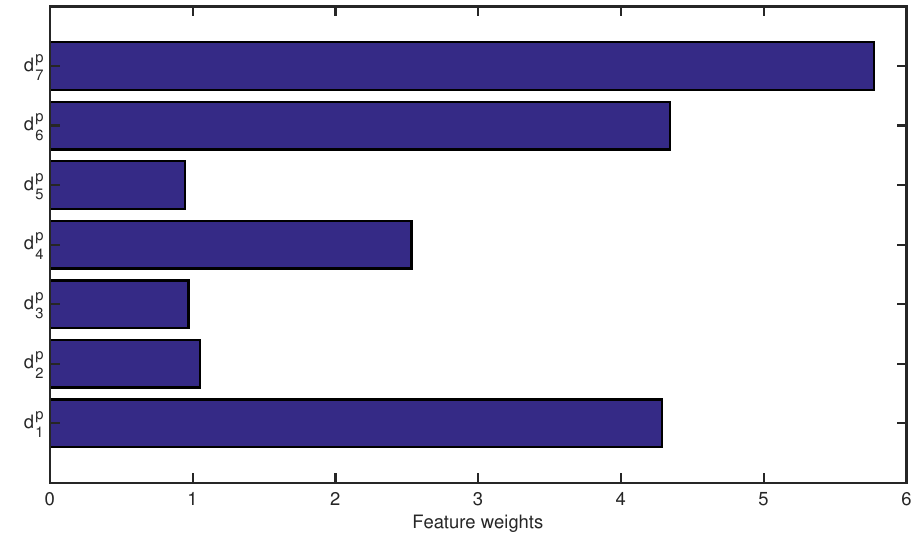
Figure 9. The optimal feature weights for TVD descriptors found by the NCFS algorithm.